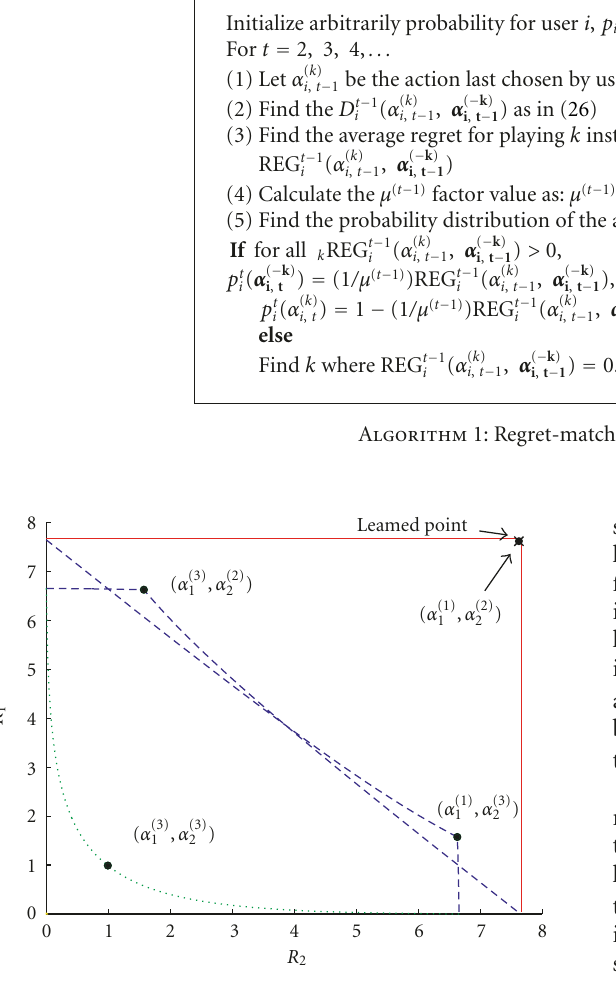
Figure 8: Crystallized rate regions in the interference limited case with marked learned